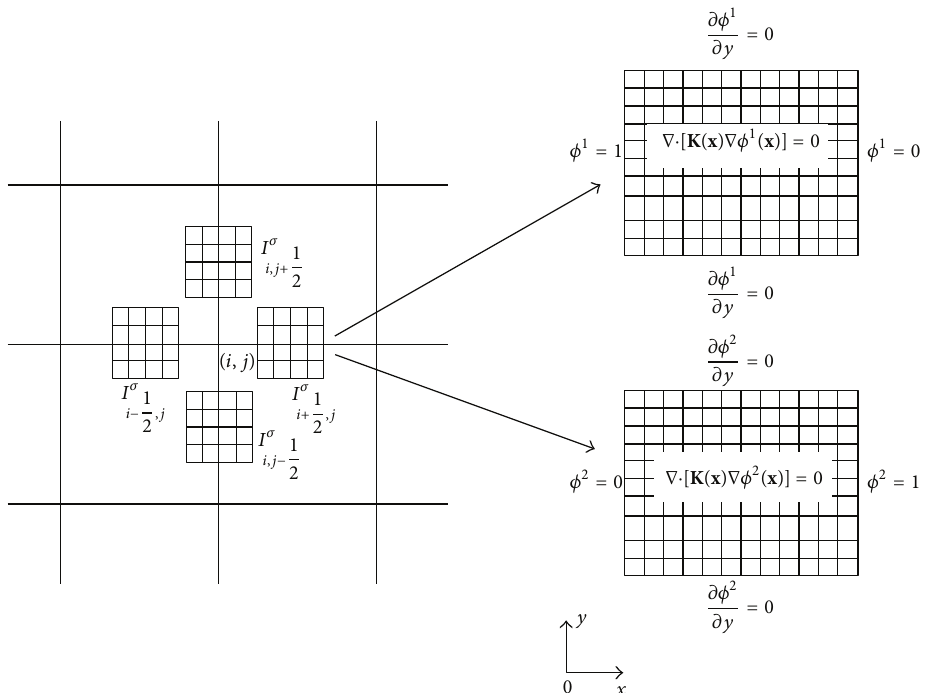
Figure 2: The control volumes at the coarse node (𝑖,𝑗) and two basic microscopic elliptic models for the control volume 𝐼 𝛿 𝑖+(1/2),𝑗